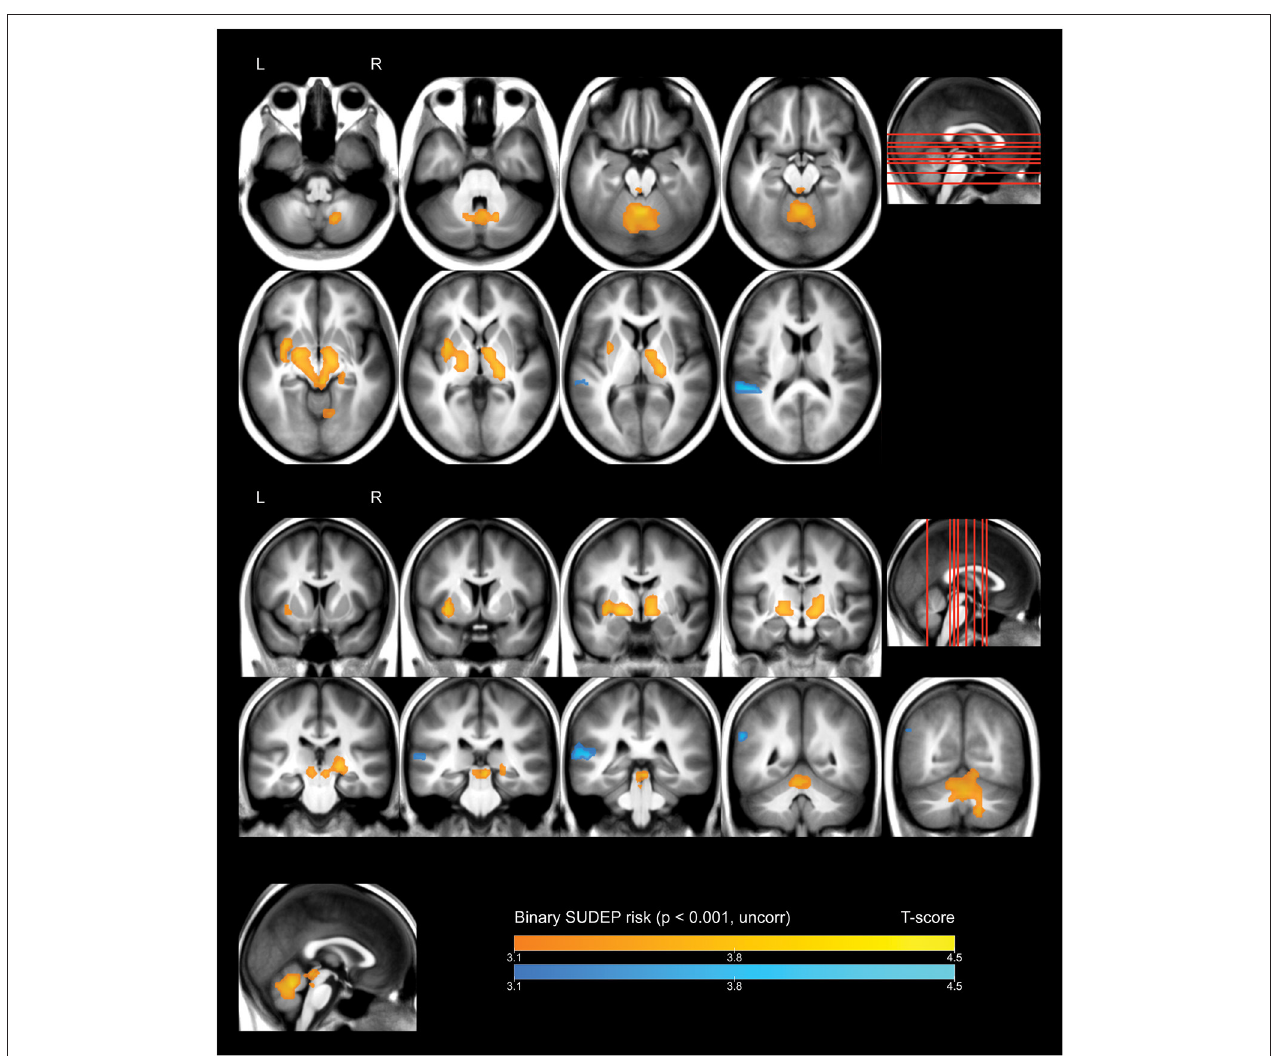
FIGURE 1 | Whole brain SPM results, high vs. low SUDEP risk. Displayed at peak height threshold T > 3.2 ( p < 0.001 uncorrected), with an extent threshold k = 110 voxels. Clusters smoothed for display purposes. Covariates included age, sex, weight, and summed intensities of high intensity voxels, ventricular voxels, and white matter voxels. Regions of increased FDG-uptake in patients at high risk of SUDEP are depicted in orange, and regions of decreased FDG-uptake are depicted in blue.